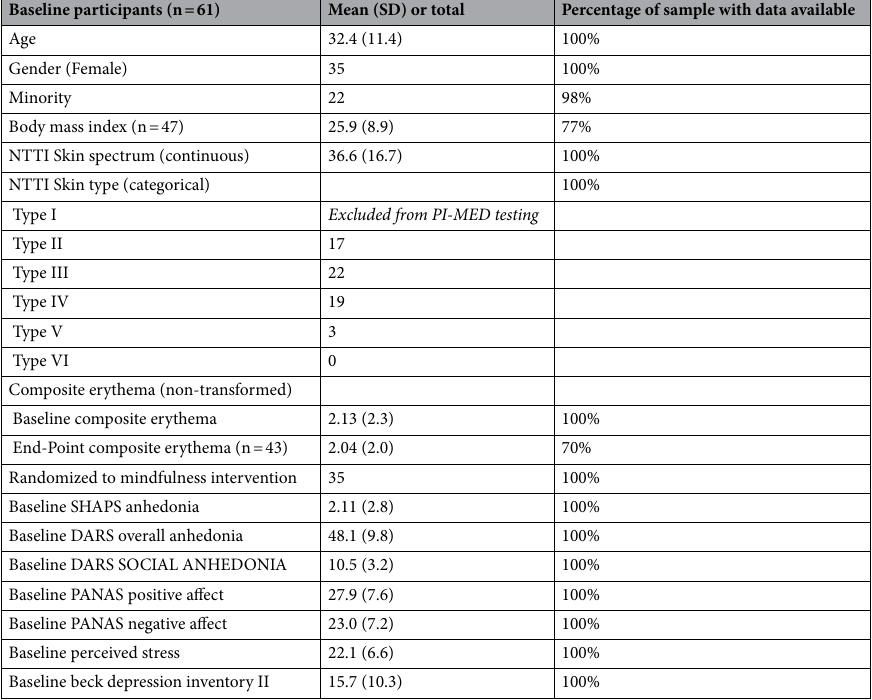
Table 1. Summary statistics for sample demographics and other variables of interest. †Composite Erythema means and standard deviations were computed on untransformed